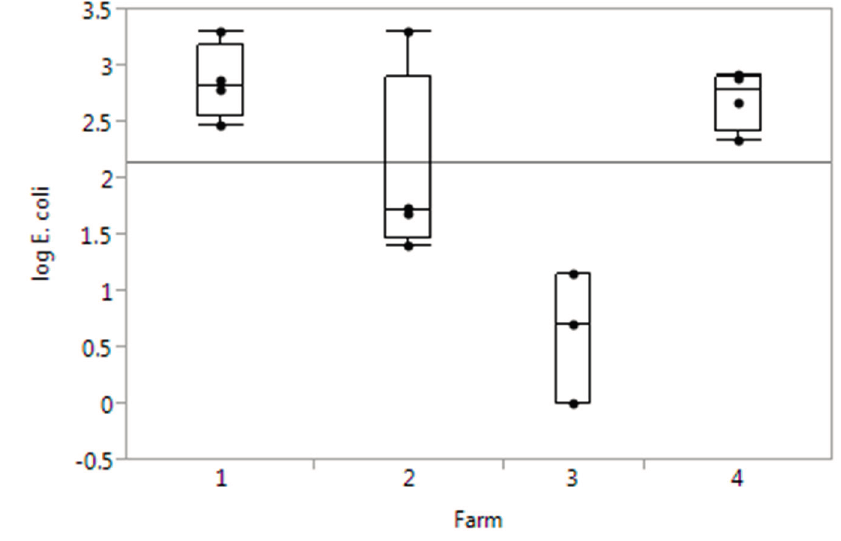
Figure 1. Boxplots of E. coli counts in water (log 10 MPN/100mL water) by farm. The horizontal line shows the overall mean